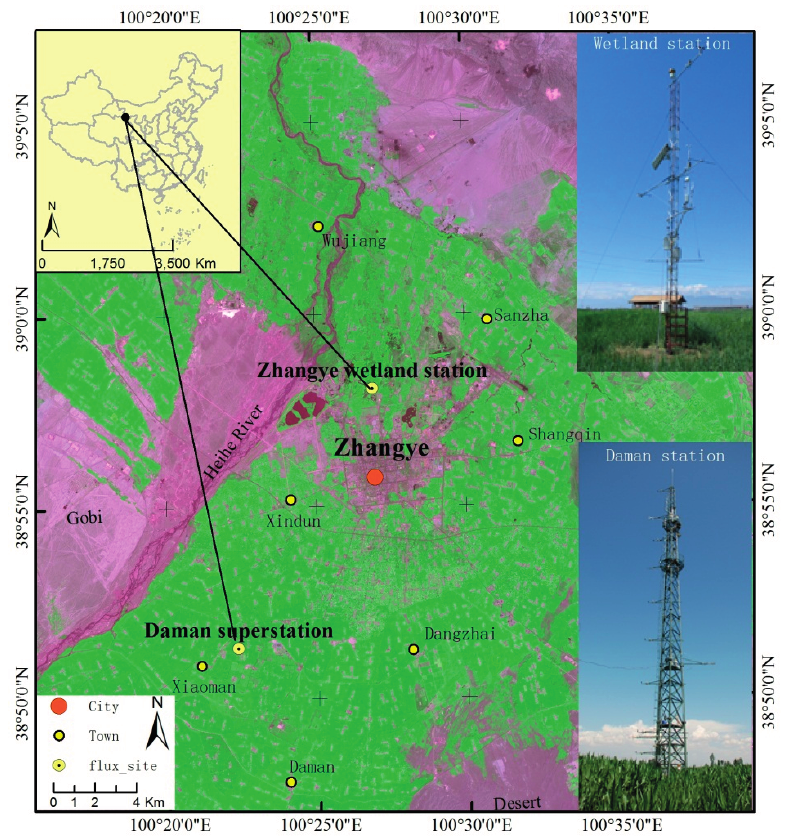
Figure 1. Location of the Daman superstation and Zhangye wetland station. (The background image is ASTER image, red: 556 nm, green: 807 nm, red: 661